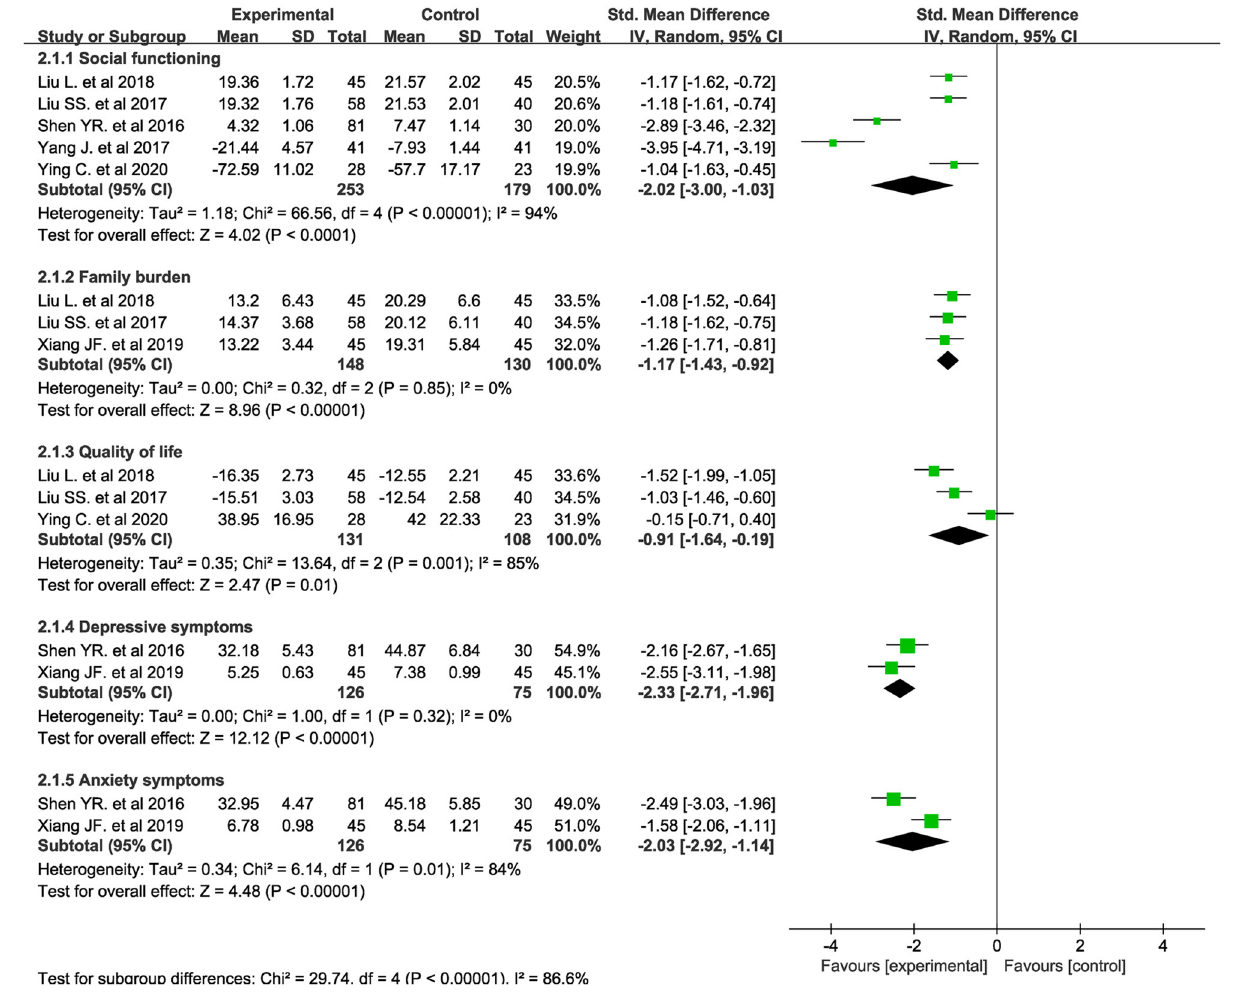
FIGURE 3 | Forest plot about the treatment effectiveness of the clubhouse model of psychiatric rehabilitation on social functioning, family burden, quality of life, and depressive and anxiety symptoms. (2) Limited studies and participants were included, and